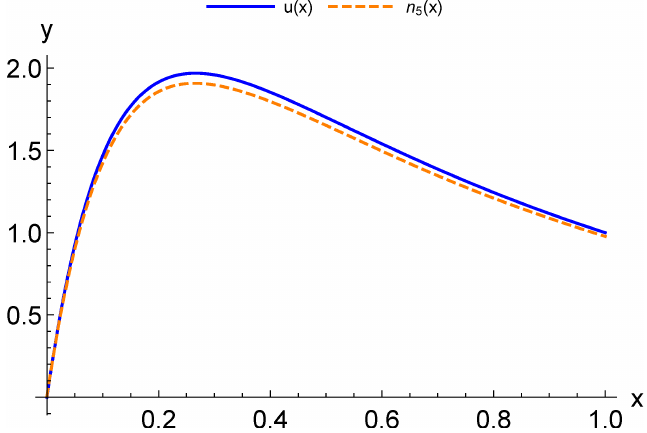
Figure 4. Plots of neural network solution n 5 ( x ) (9) (number of layers n = 5; sigmoid activation func- tions) as applied to problem (30) and its exact solution u ( x ) (parameter value s = 0.1), corresponding to dashed and solid lines, respectively.